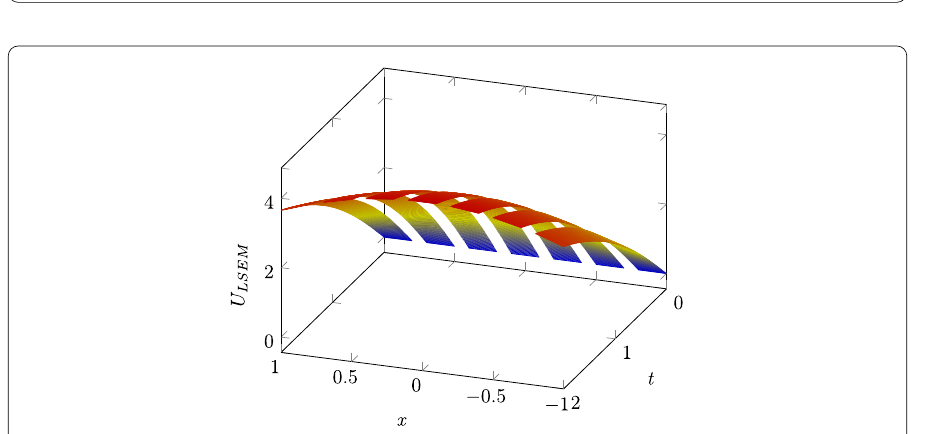
Figure 7 Comparison between the LSEM and exact solutions for Example 5.2 at t = 1 with N = 4, N e = 20, and k = 0.01